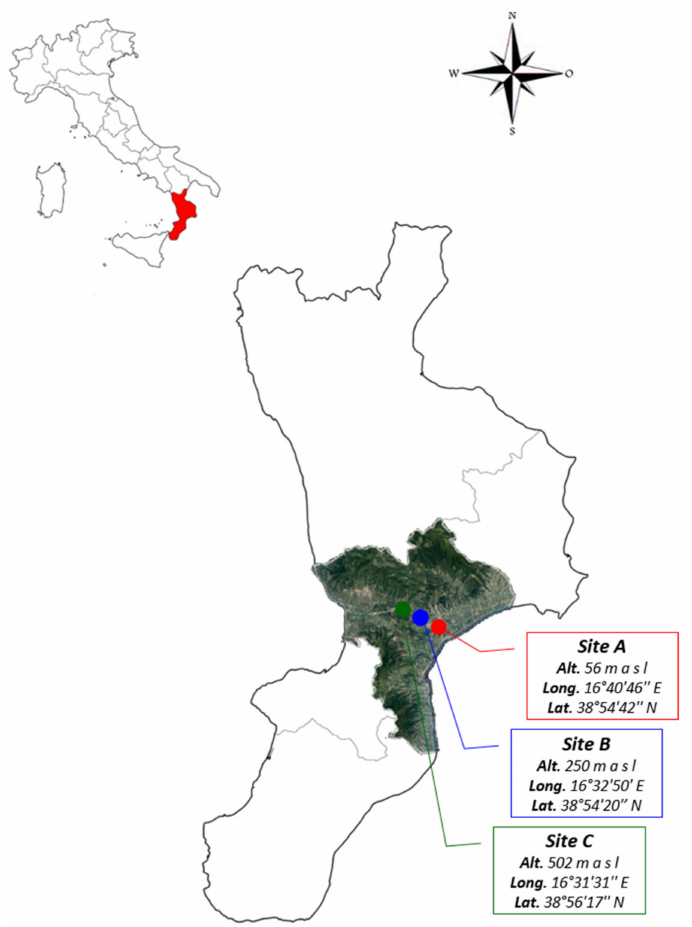
Figure 1. Location, altitude, longitude and latitude of the three study sites in Catanzaro province (Southern